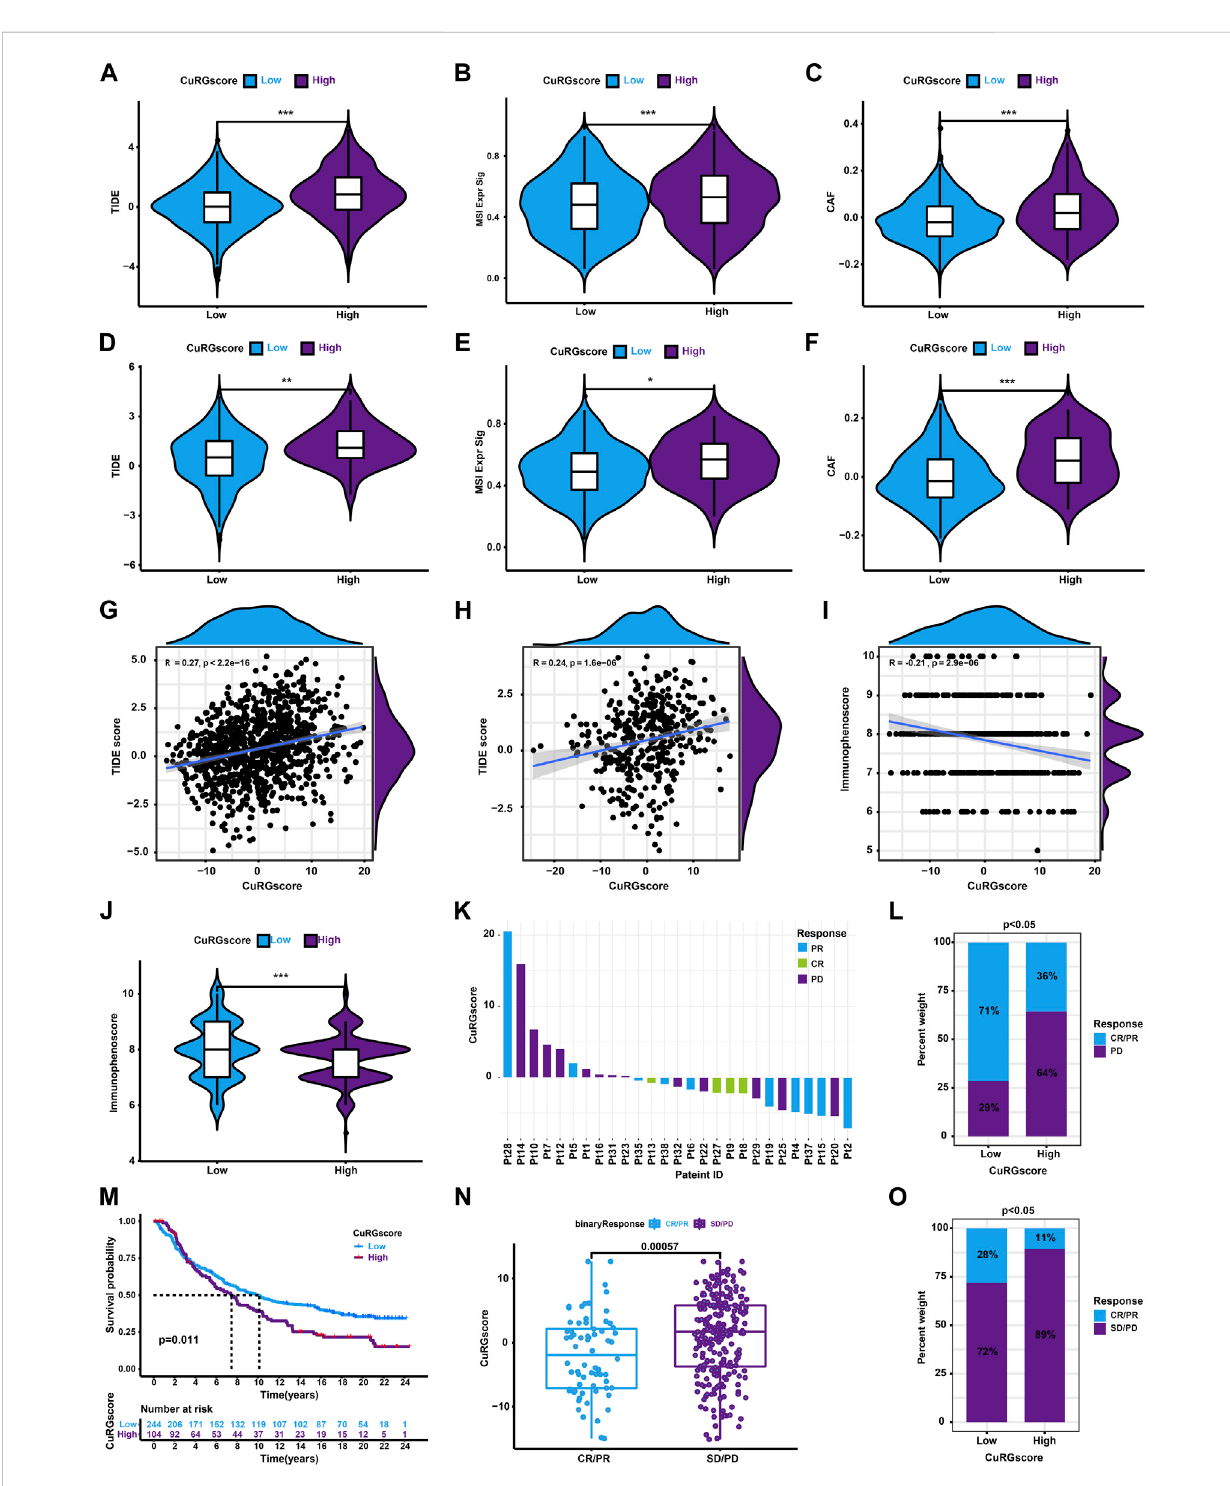
FIGURE 7 TheroleofCURGscoreinICBimmunotherapy. (A – C) ThedistributionofTIDE (A) ,MSI (B) ,andCAF (C) scoresbetweenpatientsinthehigh-andlow- CuRGscoregroupsinthetrainingcohort. (D – F) ThedistributionofTIDE (D) ,MSI (E) ,andCAF (F) scoresbetweenpatientsinthehigh-andlow-CuRGscore groups in the testing cohort. (G – I) Spearman correlation analysis for TIDE scores or immunophenoscore with CuRGscore in the training (G) , external testing (H) , and TGCA-LUAD (I) cohorts. (J) Difference of immunophenoscore between patients in the high- and low-CuRGscore groups in the TGCA-LUADcohort. (K) Distributionofpatientswithadistinctanti-PD-1clinicalresponsebasedonCuRGscoresintheGSE78220dataset. (L) Distribution of distinct anti-PD-1 clinical response in CuRGscore subgroups in the GSE78220 dataset (chi-square test). (M) Kaplan-Meier plot of overall survival for patients of CuRGscore subgroups in the IMvigor210 cohort (log-rank test). (N) The difference in the CuRGscores in anti-PD-L1 clinical response subgroups in the IMvigor210 cohort (Wilcoxon test). (O) The distribution of distinct anti-PD-L1 clinical response in high- and low-CuRGscore subgroups in the IMvigor210 cohort (chi-square test). PR, Partial Response; PD, Progressive Disease; SD, Stable Disease; and CR, Complete